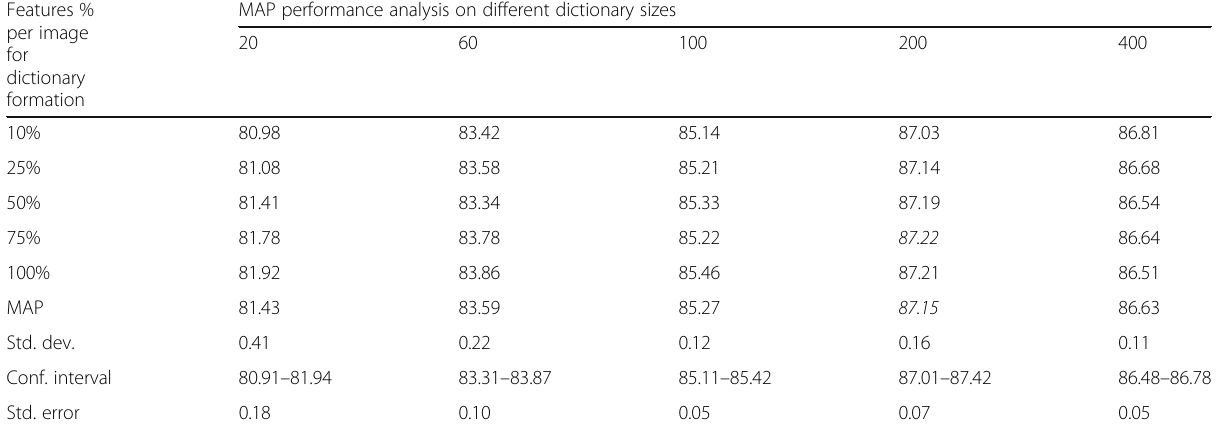
Table 1 MAP performance on the image benchmark of the Corel-1K with a step size = 10 Features % per image